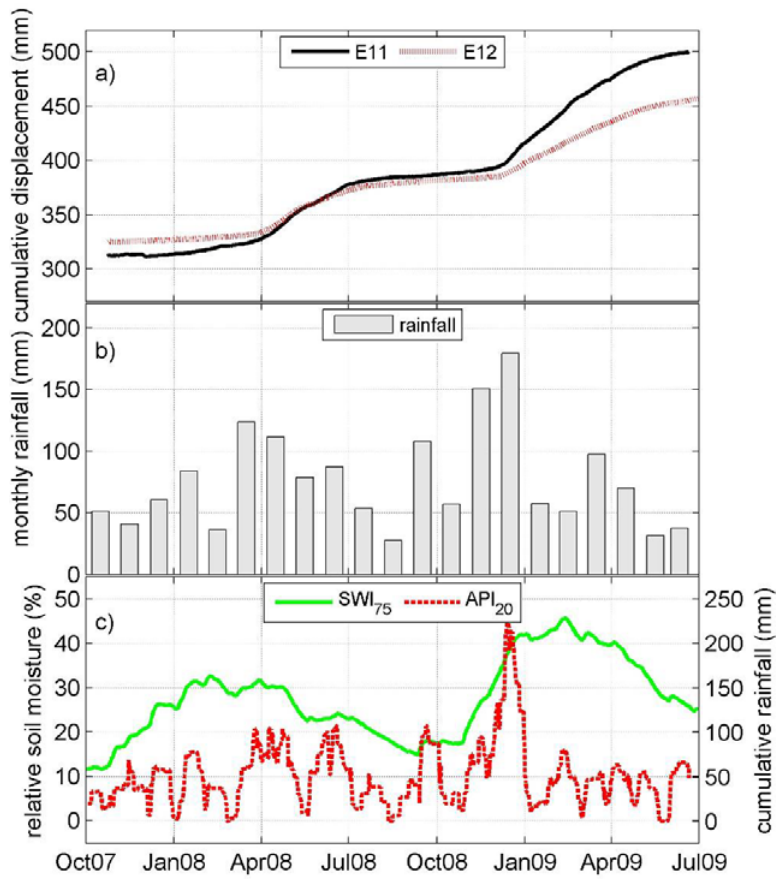
, with T = 75 days T , with N = 20 N